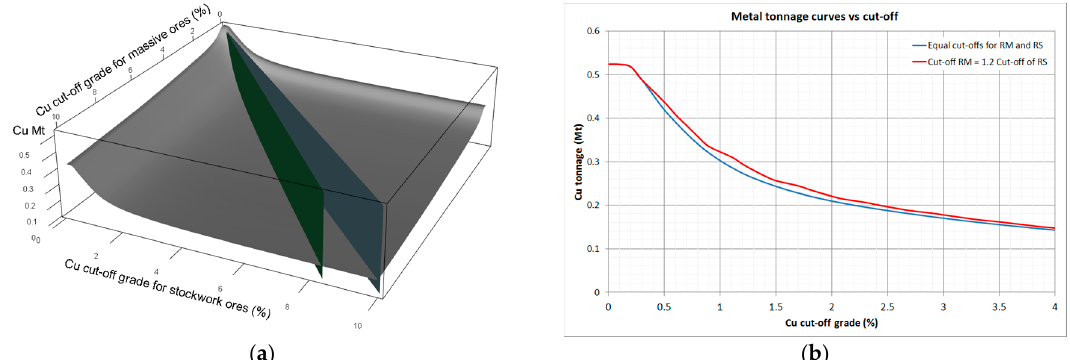
Figure 9. ( a ) Copper tonnages resources as a function of copper cut-off grades for both massive ores